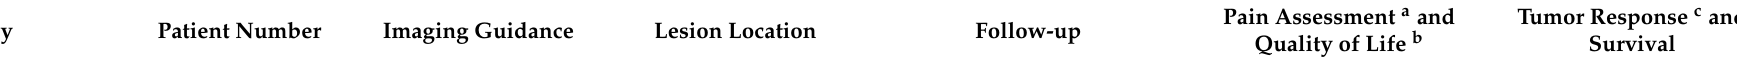
Table 2. A summary of clinical studies on HIFU treatment of primary malignant